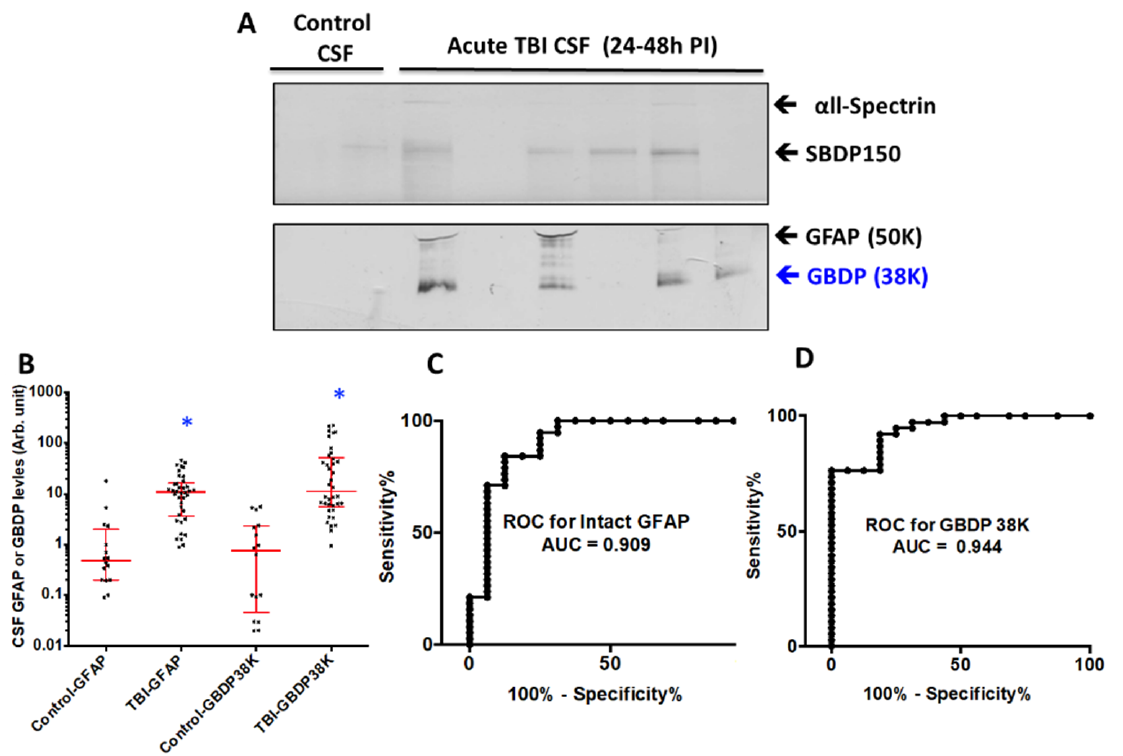
Figure 8 . GFAP and 38K GBDP in human CSF samples within 24 h of severe TBI. ( A ) Representative blots showed αll-Spectrin fragment SBDP150, intact GFAP and GBDP-38K in human control and TBI CSF samples. ( B ) Scattered plot for control and TBI CSF (collected within 24 h post-admission). Groups are shown as the median and interquartile range (IQR), * p < 0.05. Control has N = 12, TBI N = 30. ( C , D ) ROC showed higher AUC for GFAP-38K (0.944) that intact GFAP (0.909)